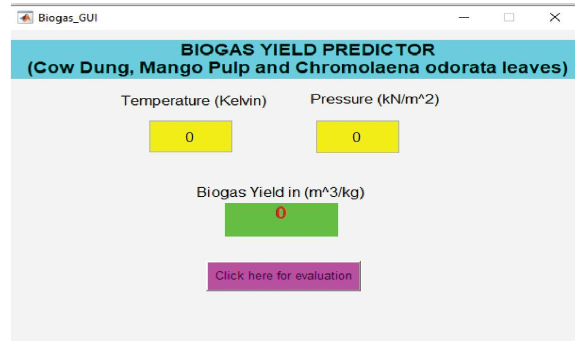
Figure 9: Graphical user interface, GUI for biogas yield